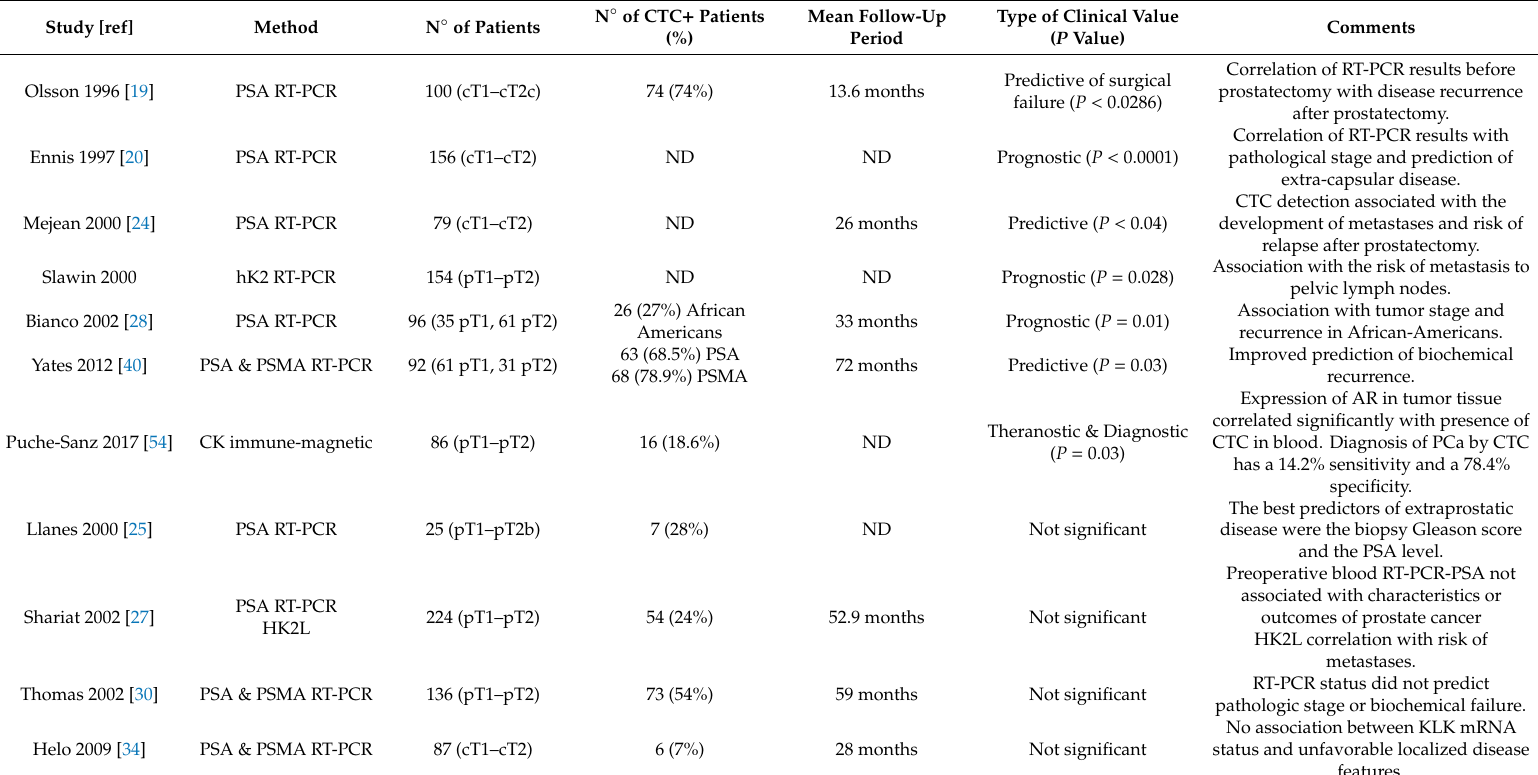
Table 2. The clinical value of Circulating Tumor Cells‘ (CTC) detection in patients with localized prostate